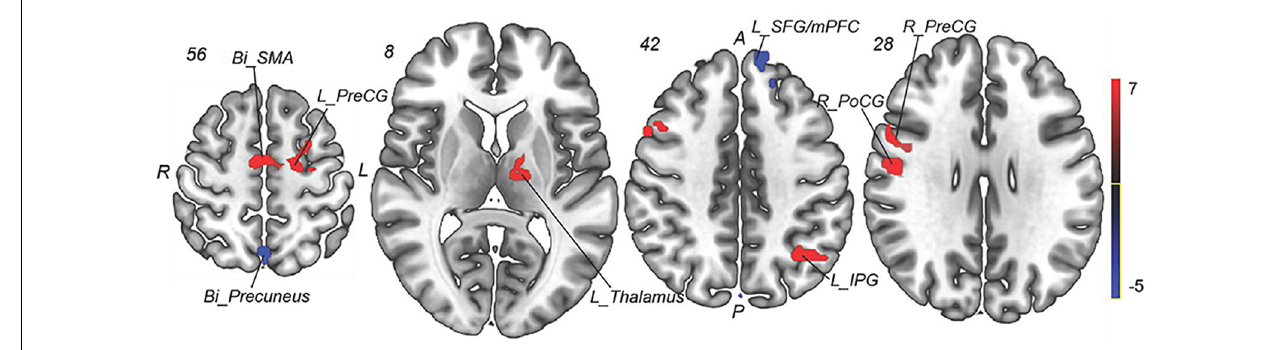
FIGURE 3 | Group comparison of fALFF between the MWoA patients and HCs. Compared with HCs, pretreatment MWoA patients exhibited increased fALFF in the left thalamus, left IPG, bilateral PreCG, right PoCG, and bilateral SMA, but decreased in the bilateral precuneus and left SFG/mPFC. Red colors indicate regions with increased fALFF; blue colors indicate regions with decreased fALFF. Bi, bilateral; R, right; L, left; PoCG, postcentral gyrus; PreCG, precentral gyrus; SPG, superior parietal gyrus; SMAs, supplementary motor areas; SFG, superior frontal gyrus; mPFC, medial prefrontal cortex; IPG, inferior parietal gyrus.